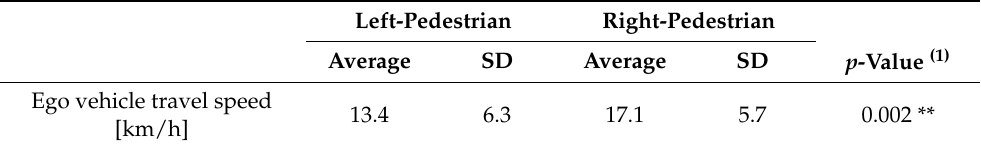
Table 4. Average of ego vehicle travel speed in the presence of Left-Pedestrian and Right-Pedestrian.